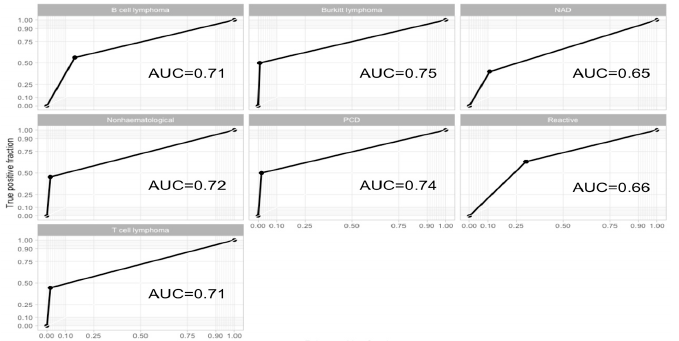
Figure 3. ROC curves and AUC assessing the agreement between FNA FC and histology. NAD: no abnormalities detected; PCD: plasma cell dyscrasia; NK cell lymphoma: natural killer cell lymphoma; Non-hematological: non-hematological malignancy. ROC: receiver operating characteristics. AUC: Area under the Curve.